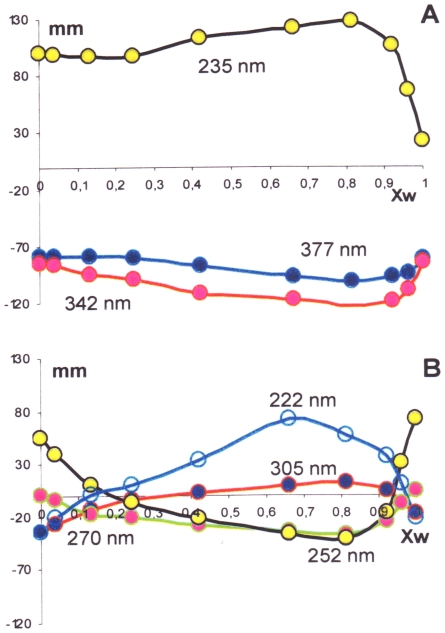
Elongations of the dichroic bands of biisocolchicide with respect to the mole fraction of water.The CD elongations (mm) of 377, 342 and 235 (A) and 305, 270, 252 and 222 nm (B) dichroic bands, derived from the spectra in Figure 4, with respect to the mole fraction of water are reported.